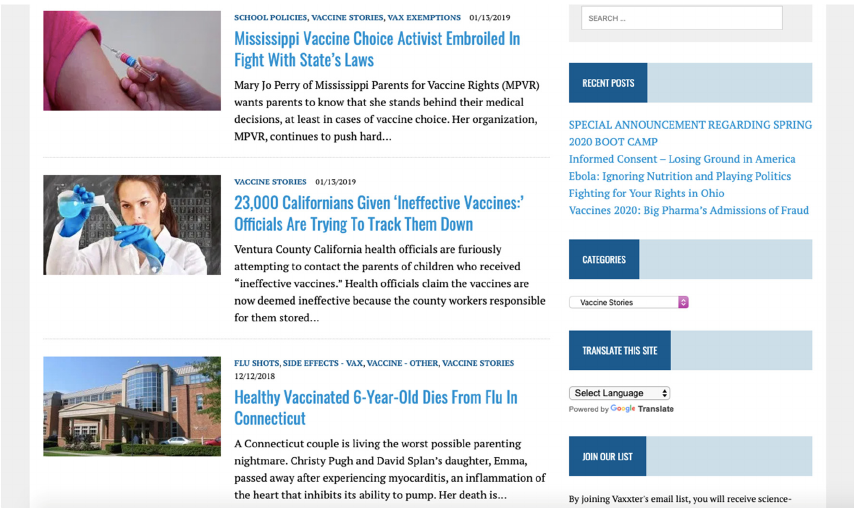
Figure 2. Vaxxter website “News” page (https://vaxxter.com/category/uncategorized/vaccine-tales/, accessed on 2 November 2021).